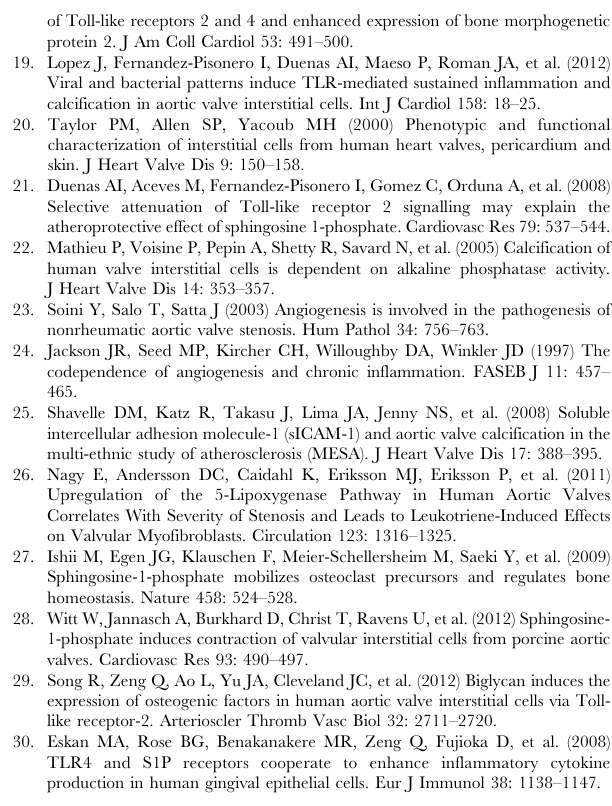
observed. Figure S2 Knock-down of S1P receptor mRNA expres- sion by siRNA technique. Cells were transfected with RNA duplex that inhibited mRNA expression of the indicated S1P receptor genes, or a siRNA control (scramble) or the vehicle. Plots represent the quantitative PCR profiles in comparison with the housekeeper gene b -actin. Images are representative of 3 independent experiments. Table S1 Summary of Statistical Analysis. Detailed information on the statistics corresponding to the indicated figures is